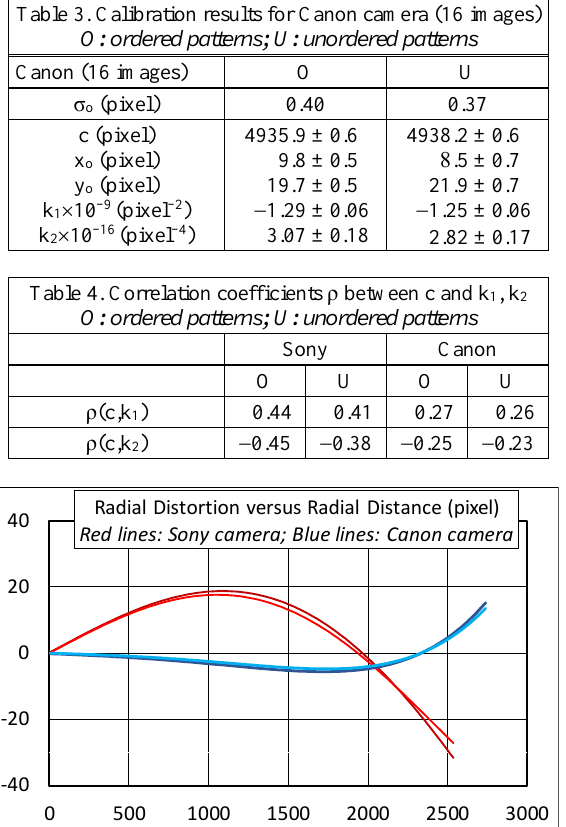
Figure 13. Calibrated radial distortion curves of the two cameras using both ordered and unordered